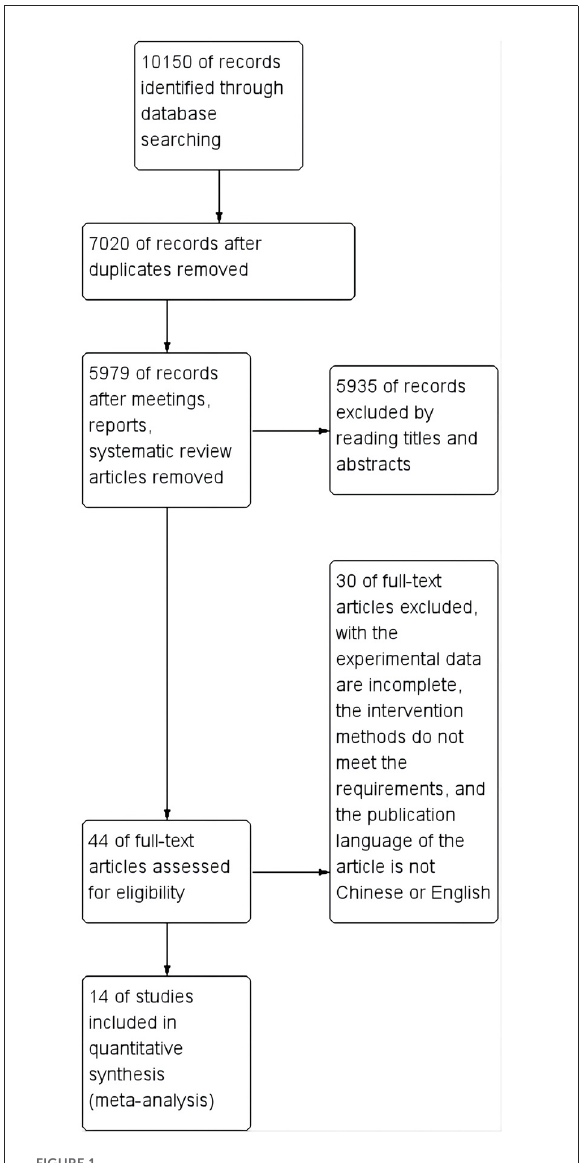
FIGURE1 Flow diagram of study selection and